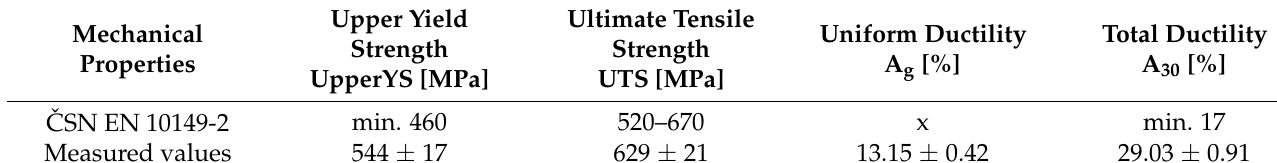
Figure 2. EBSD analysis of the base material. Table 2. Basic mechanical properties of tested material—steel S460MC.